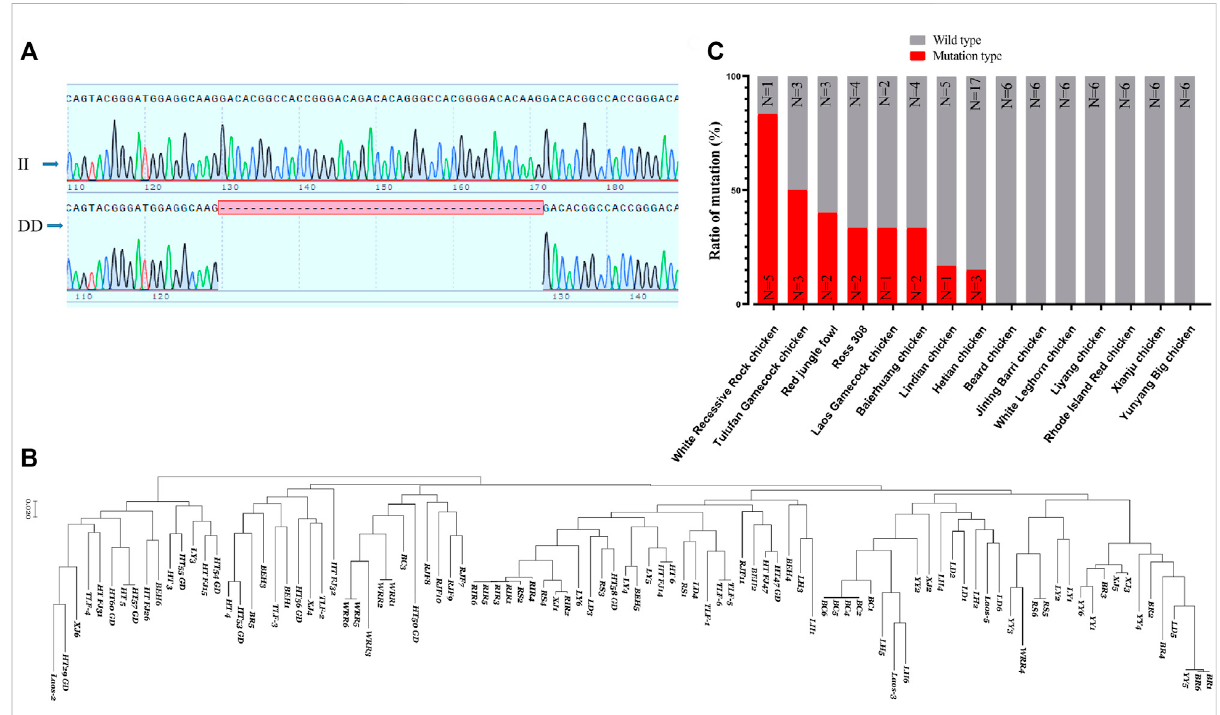
FIGURE 7 Polymorphism of Chicken RPL3L . (A) The 42 bp indel of chicken RPL3L ; (B) evolutionary tree diagram of RPL3L in different chicken breeds; (C) mutation ratio of RPL3L 42 bp indel in different chicken breeds. BC, Huiyang Bearded Chicken; WRR, White Recessive Rock Chicken; HT, Hetian chicken; BEH, Baier Yellow chicken; XJ, Xianju chicken; LY, Liyang chicken; BR, Jining Bairi chicken; YY, Yunyang Da chicken; LD, Lindian chicken; TLF, Tulufan gamecock chicken; LH, White Leghorn chicken; RS, Cobb RS308 chicken; RIR, Rhode Island Reds; RJF, Red jungle fowl chicken; and Laos, one gamecock population from